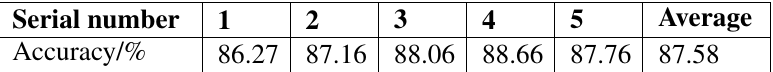
Table 2 Diagnosis results based on the feature amount of the colour